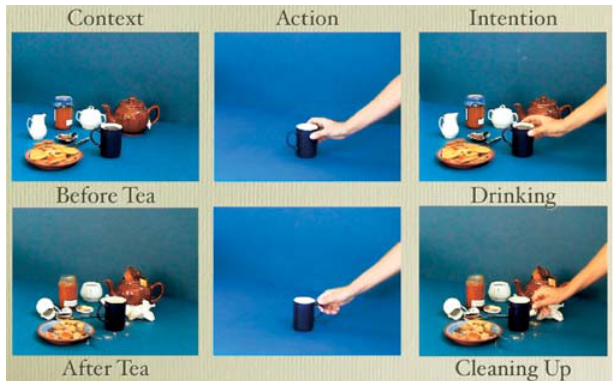
Figure 1. Six Images Taken from the Context, Action, and Intention Clips The images are organized in three columns and two rows. Each column corresponds to one of the experimental conditions. From left to right: Context, Action, and Intention. In the Context condition there were two types of clips, a ‘‘ before tea ’’ context (upper row) and an ‘‘ after tea ’’ context (lower row). In the Action condition two types of grips were displayed an equal number of times, a whole-hand prehension (upper row) and a precision grip (lower row). In the Intention condition there were two types of contexts surrounding a grasping action. The ‘‘ before tea ’’ context suggested the intention of drinking (upper row), and the ‘‘ after tea ’’ context suggested the intention of cleaning (lower row). Whole-hand prehension (displayed in the upper row of the Intention column) and precision grip (displayed in the lower row of the Intention column) were presented an equal number of times in the ‘‘ drinking ’’ Intention clip and the